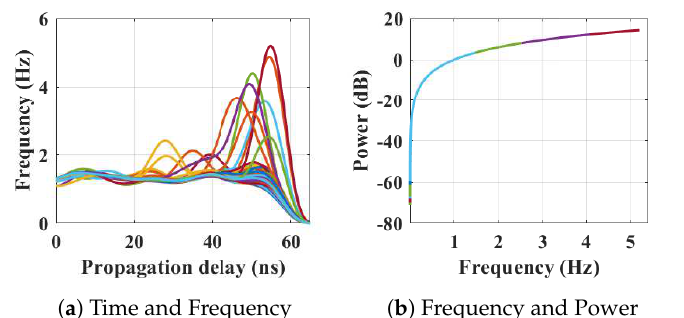
Figure 11. The relationship between propagation delay, activity frequency, and received power from the radar responses obtained while the person is brushing their teeth in the bathroom has been considered as C8 in classification phase.